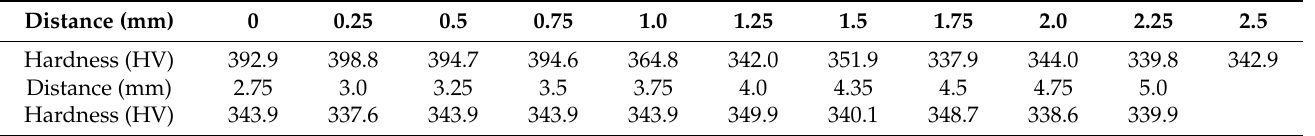
Table 5. Measurement values of micro-hardness distribution of LBW weldment starting from weld